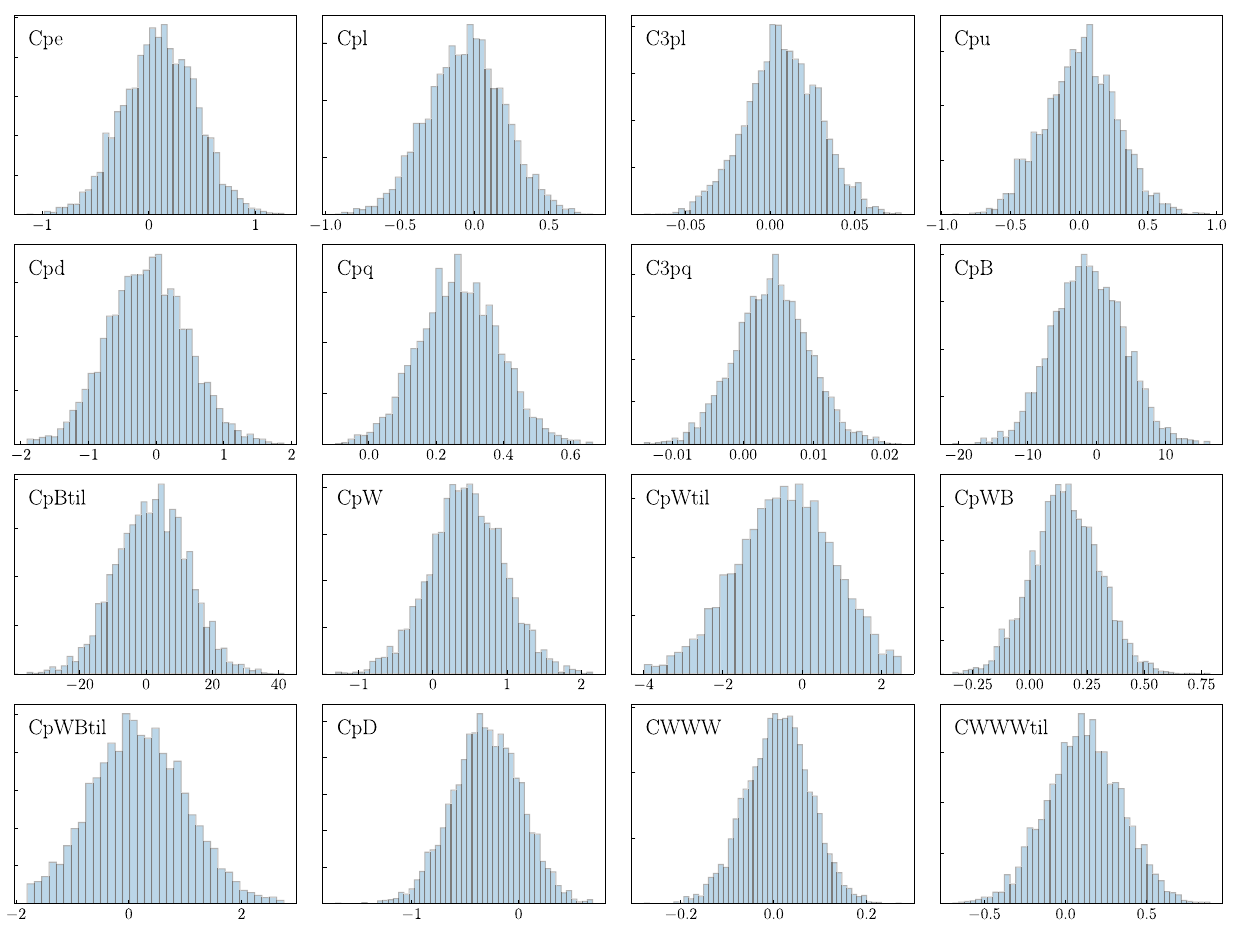
Fig. 19 The posterior probability distributions associated to each of the n op = 16 coefficients that are constrained in this analysis for the baseline dataset. Note that the x -axis ranges are different for each